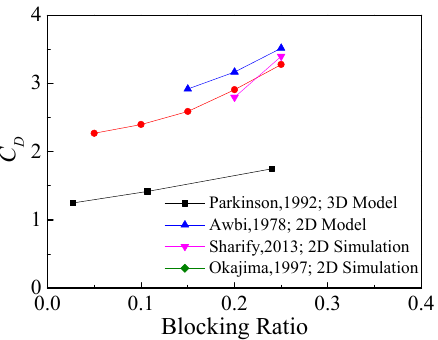
Figure 7. C D varies with blockage ratio [5,10,37,38].